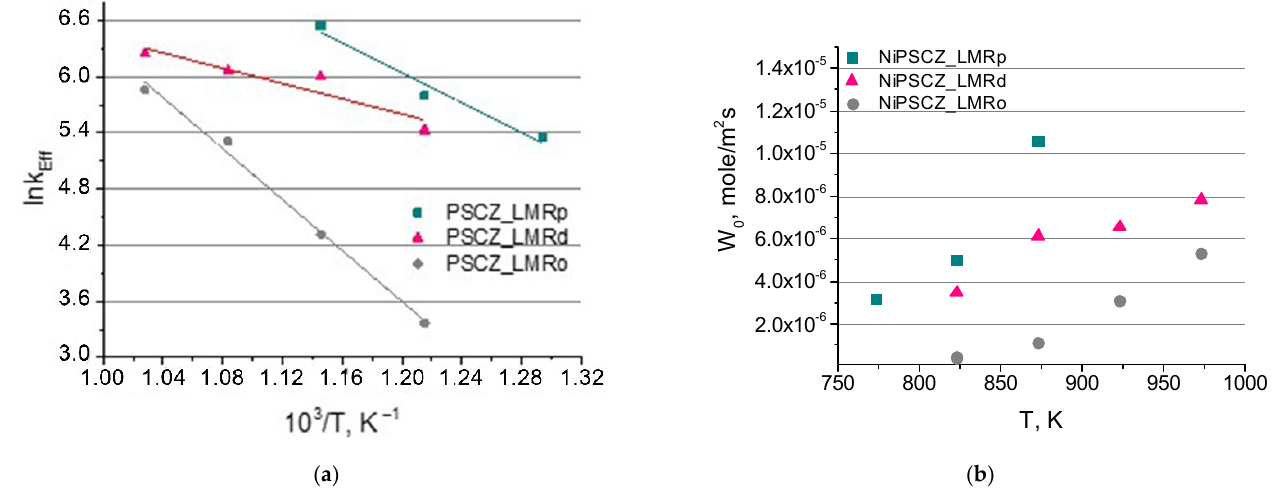
Figure 4. ( a ) Linearized Arrhenius equation and ( b ) initial reaction rate W 0 for NiPSCZ_LMRp, NiPSCZ_LMRd and NiPSCZ_LMRo in ethanol steam reforming reaction in 500–600 °C temperature range. Table 2. Kinetic regularities calculated for NiPSCZ_LMR and PSCZ_LMNiR *